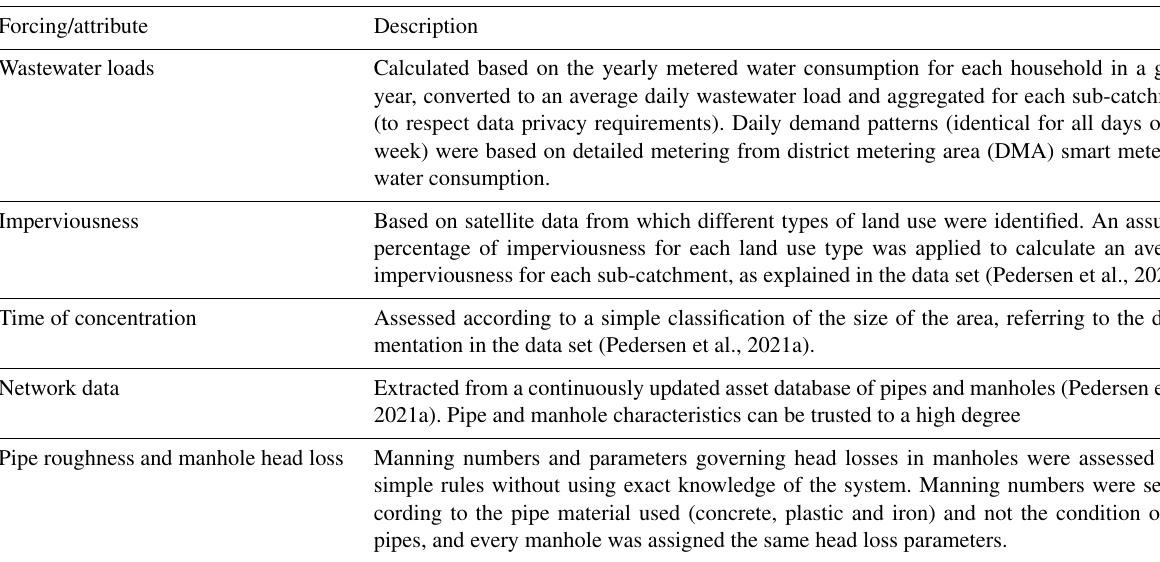
Table 3. Determination of model forcings and attributes in the implemented MU model from independent data sources.